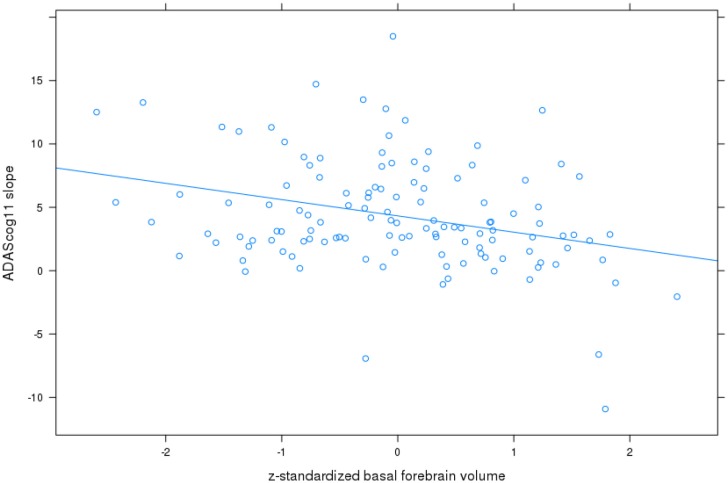
Basal forebrain volume and rates of change in ADAScog11. Plot of z-standardized basal forebrain volume on mixed effects linear model estimates of rates of change in ADAScog score controlling for age and sex, with linear regression line.